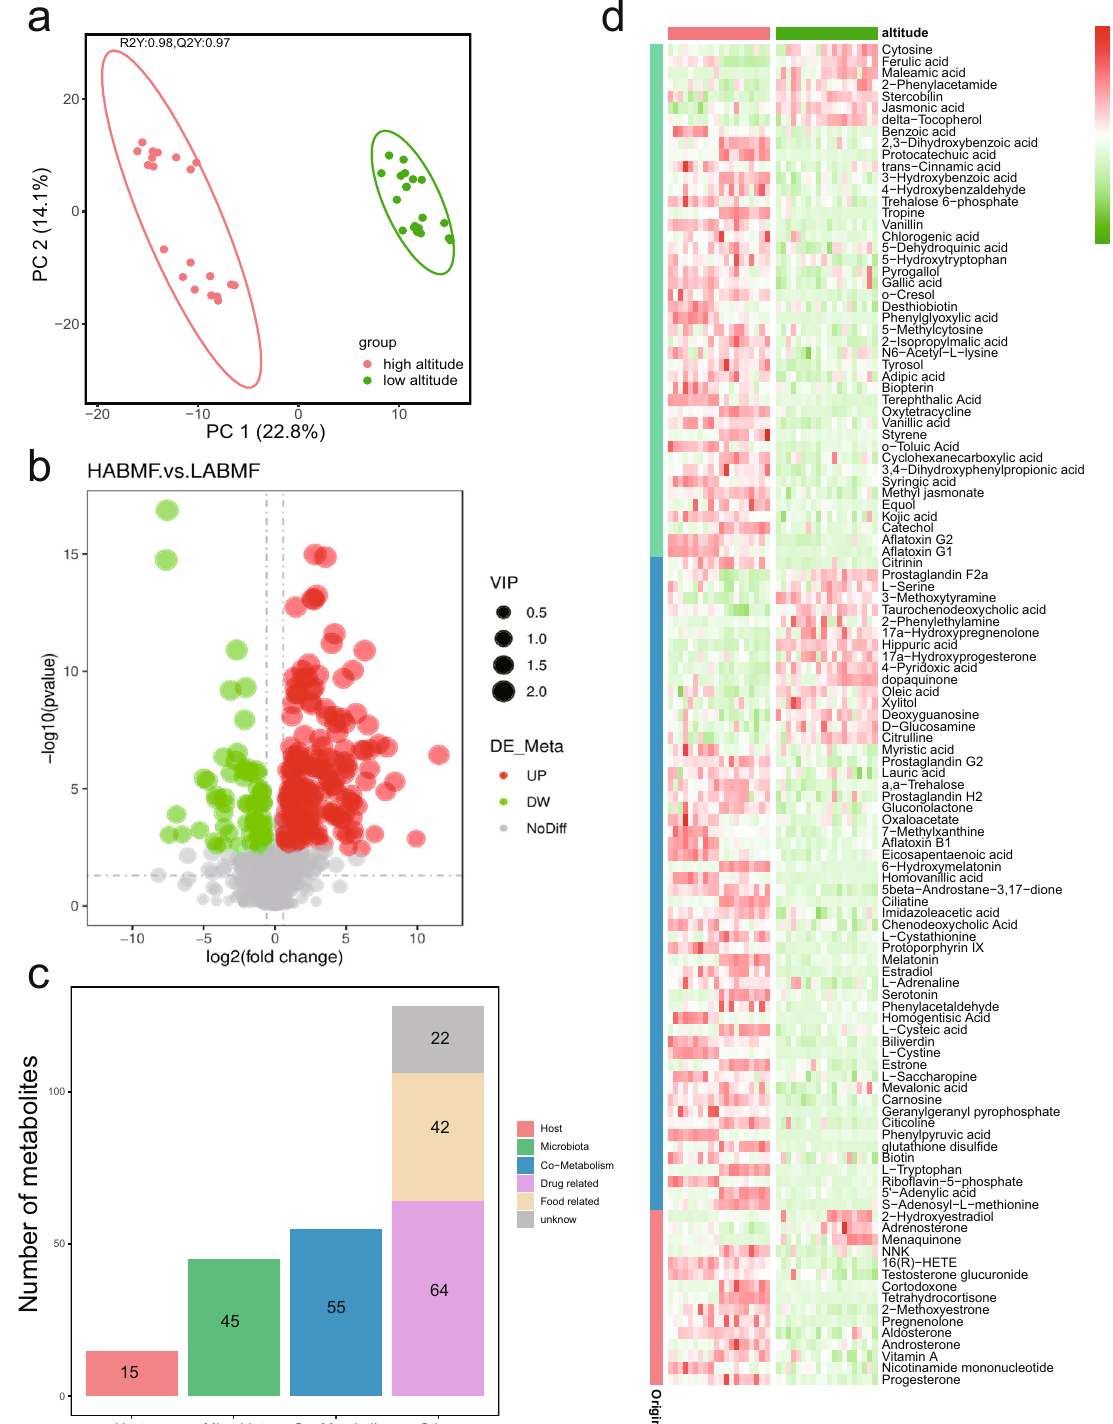
Fig. 4 Abundance differences and source pro fi les of metabolites annotated by KEGG database in feces of RMs at high versus low altitude. a PCA analysis showed the pattern of separation between the two groups after PLS-DA analysis 200 permutation test model validation, The ellipse borders represent the 95% con fi dence interval. b Volcano map of differential metabolites between the two groups, red indicates that the relative abundance was signi fi cantly higher at high altitudes, and green indicates that the relative abundance was signi fi cantly higher at low altitudes. c Differential metabolite source pro fi les. d Heatmap of differential metabolite abundance from host, microbiota and